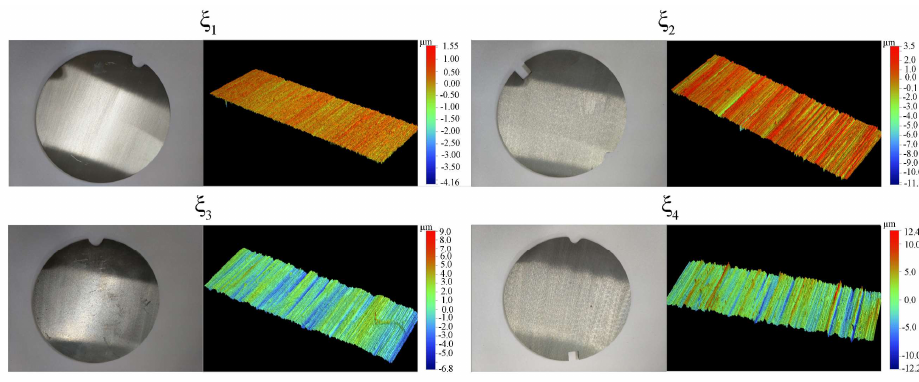
Figure 2. Impinged plates with microscopic surface